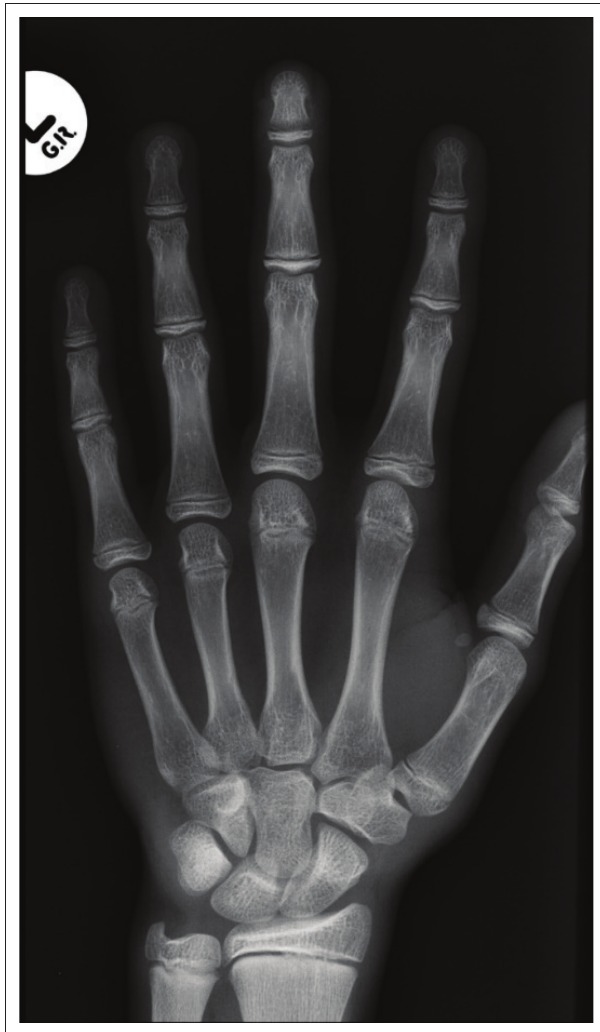
FIGURE 1: Digital hand-wrist radiograph (right) of a female subject with a chronological age of 20 years 8 months was matched to the GP standard image of a 17-year-old by both readers.